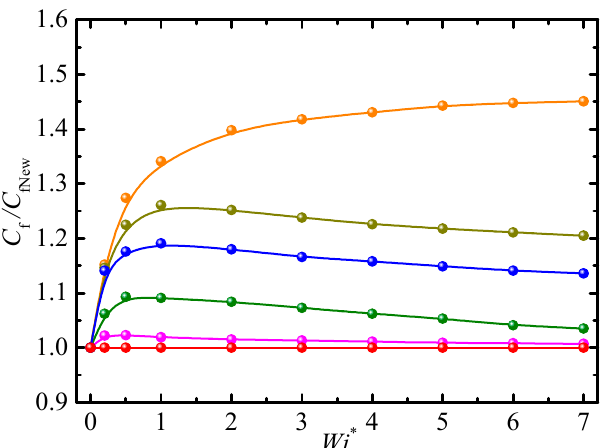
Figure 5. Friction factor vs. modified Weissenberg for different viscosity ratios ( Φ =1.0%, Re = 2.5, α = 0.2). ⸺ ● ⸺ : β 0 =1.0; ⸺ ● ⸺ : β 0 =0.9; ⸺ ● ⸺ : β 0 =0.3; ⸺ ● ⸺ : β 0 =0.2; ⸺ ● ⸺ : β 0 =0.1; and ⸺ ● ⸺ : β 0 = 0.